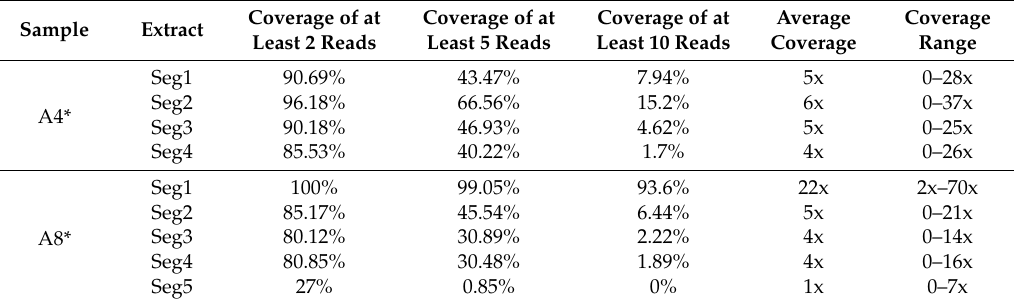
Table 10. mtGenome coverage of one segmented aged hair segments extracted with Protocol B.